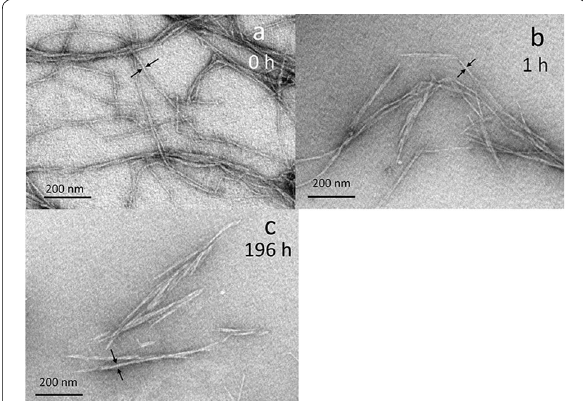
Fig. 3 Transmission electron microscopy images of negative stained bagasse cellulose a before saccharification, b after saccharification for 1 h, and c after saccharification for 196 h. Each pair of arrows indicates the measured width